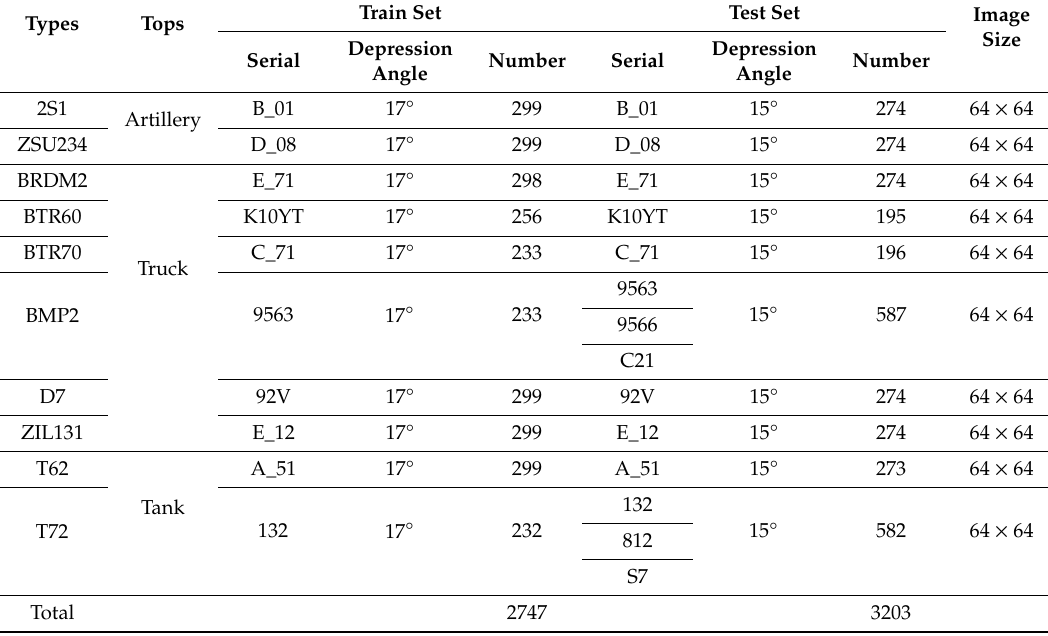
Figure 6. MSTAR dataset image example. Table 2. 10-class MSTAR dataset configuration under Standard Operating Condition (SOC).